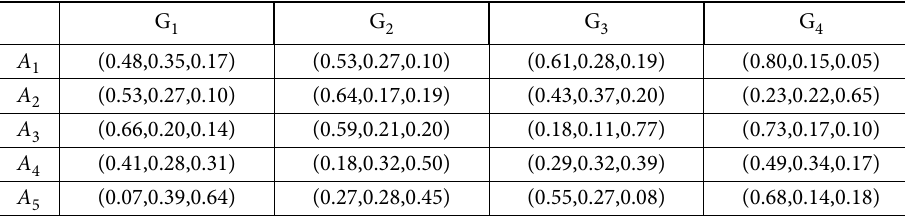
Table 2. Picture fuzzy evaluation information by E 2